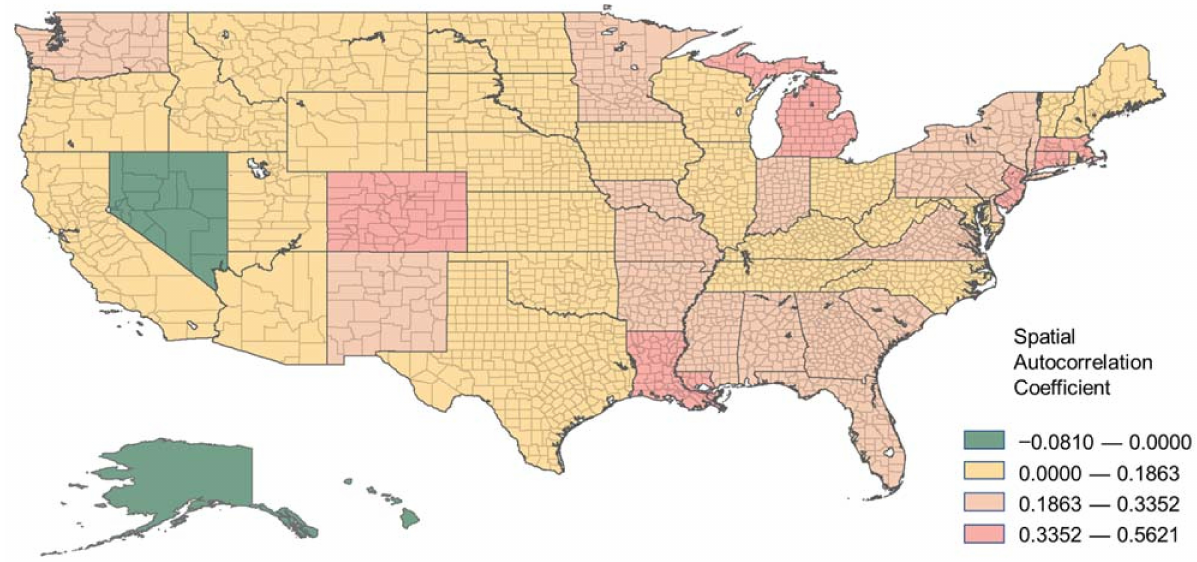
Figure 6. The choropleth map of spatial correlation coefficient λ . For the choropleth map of the spatial correlation coefficient λ , shown in Figure 6, we used the Jerkens breakpoints with four